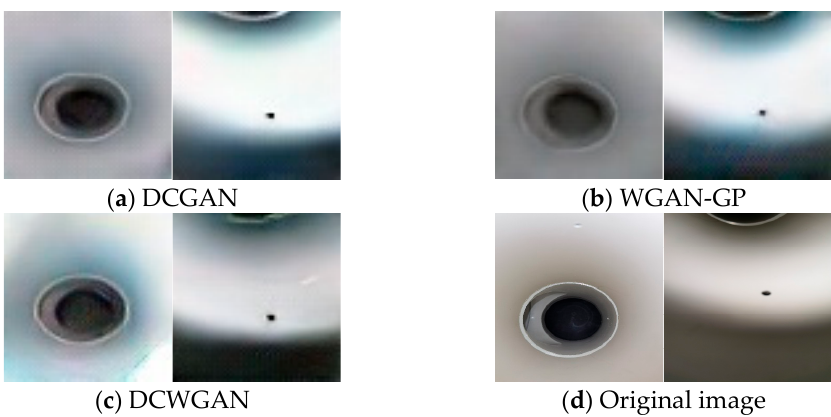
Figure 13. The generated image of each network is compared with the original graph.